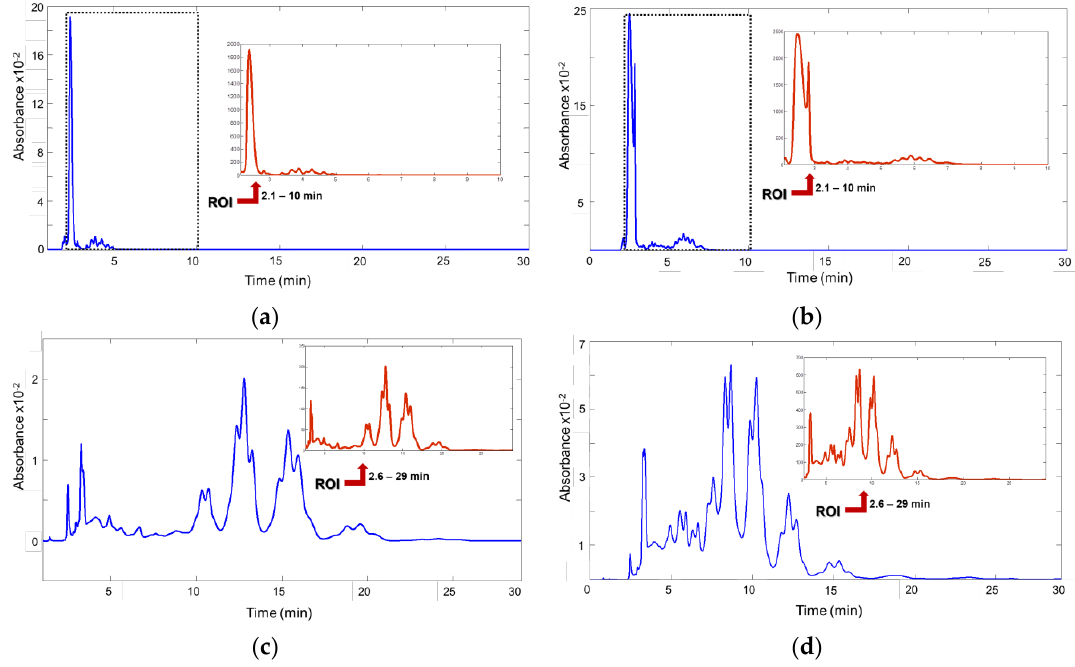
Figure 1. Chromatogram of a margarine/spread samples showing the region of interest used to build the classification models: ( a , b ) Normal phase from Morocco and Spain, respectively; ( c , d ) reverse phase from Morocco and Spain, respectively.